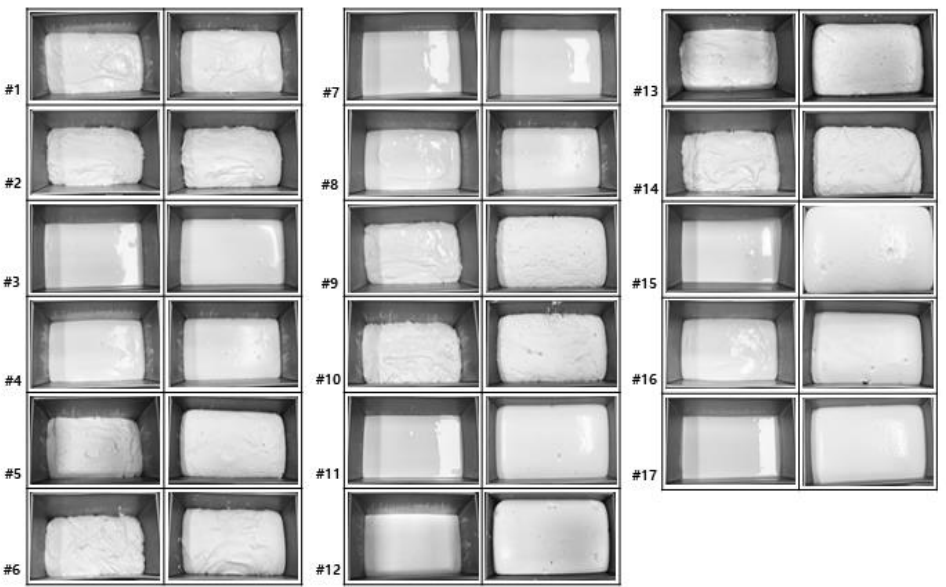
Figure 1. Appearance of batter prepared as per the designed formula and processing conditions before ( left ) and after ( right ) fermentation.